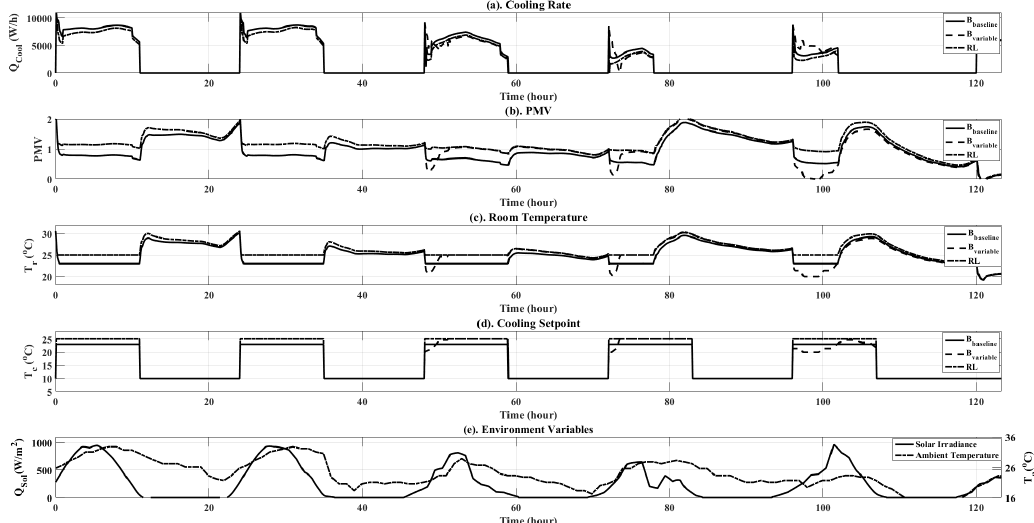
Figure 11. Simulation results plots for comparison between B ideal , B variable and the RL controller over the five-day validation runs. Plots are shown for both objective variables ( Q cool and PMV), as well as additional simulation data, such as ambient temperature and solar